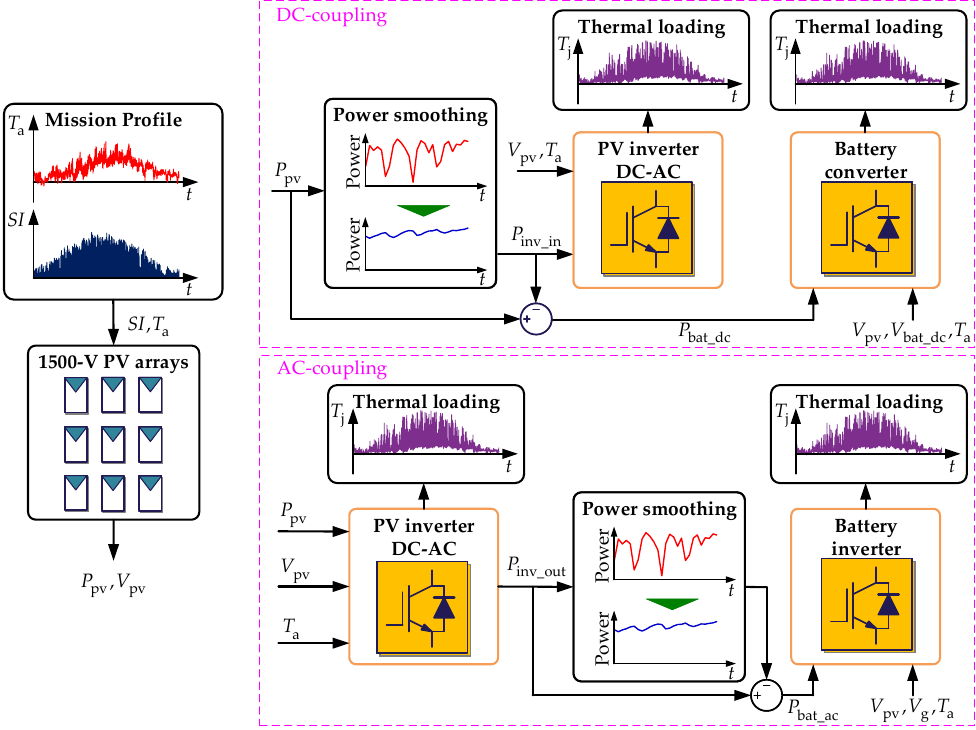
Figure 2. Schematic of the system modeling for the DC- and AC- coupling 1500 V PV